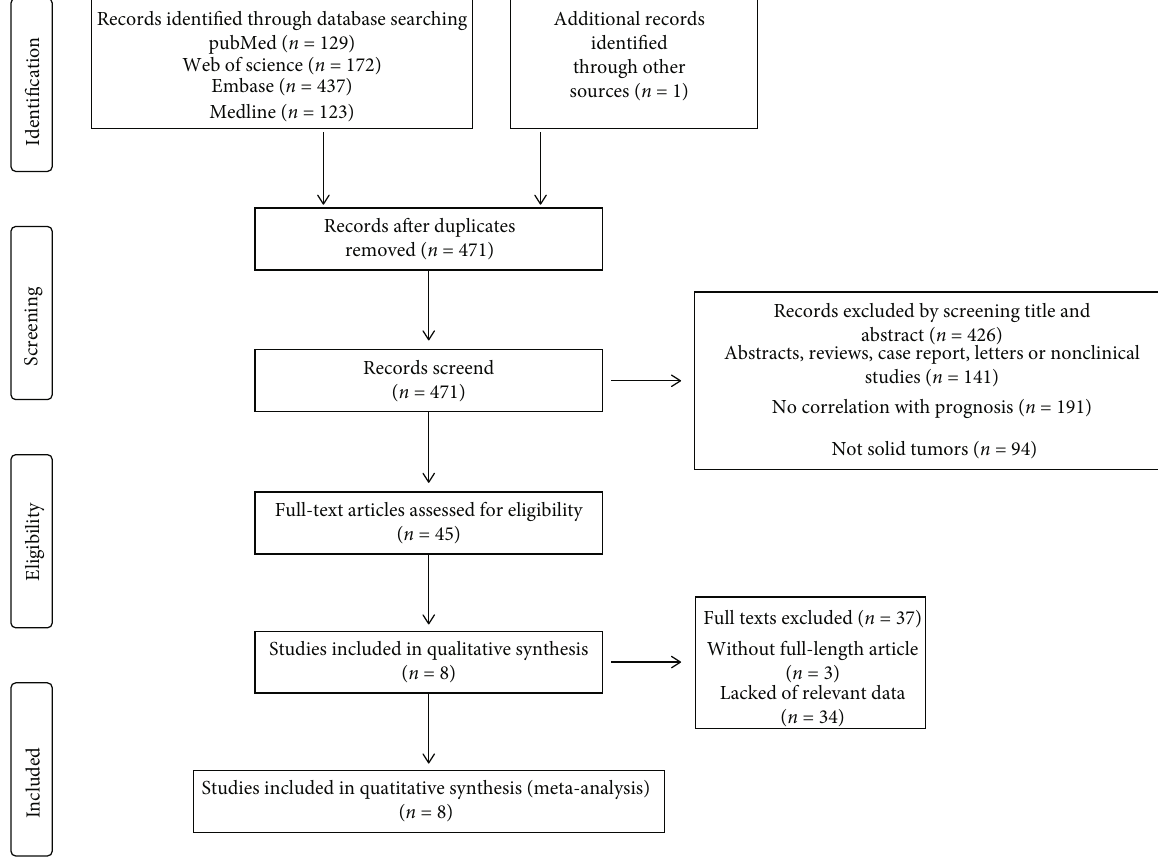
Figure 1: Literature screening process and results. Table 1: Basic characteristics of included